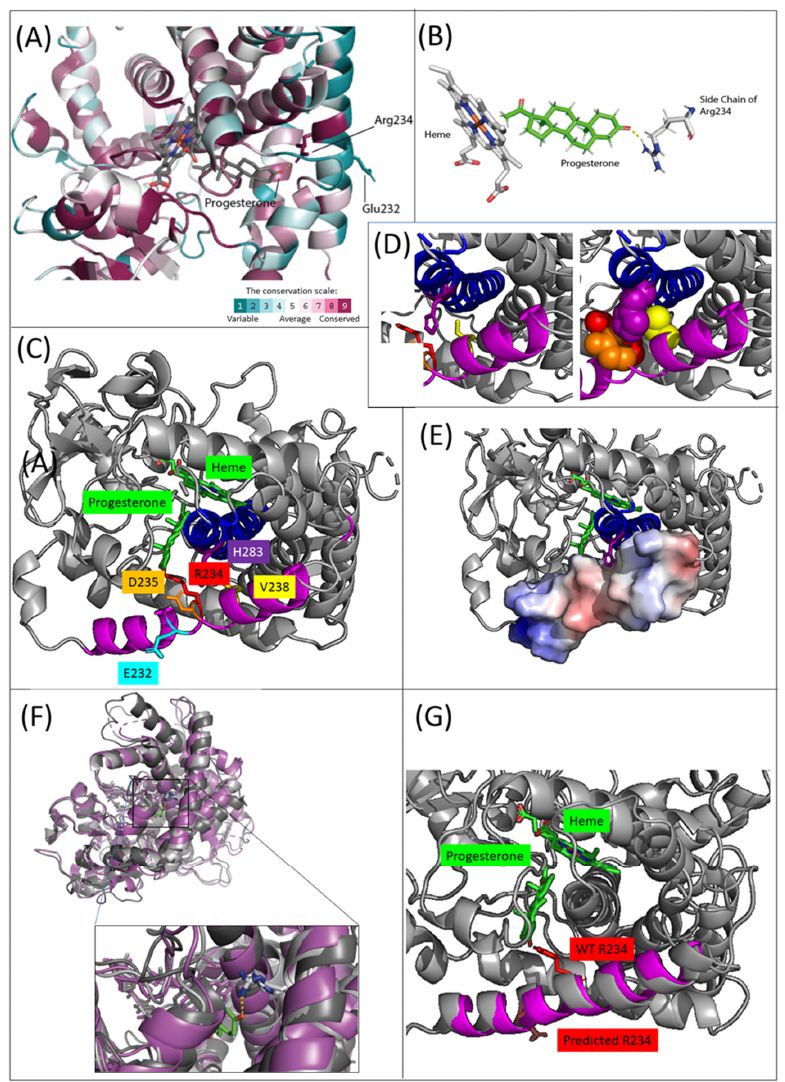
Figure 1. Highlighting evolutionary and structural information relevant to our case in the CYP21A2 structure. Legend: ( A ): the relevant part of the CYP21A2 structure colored by evolutionary conservation. The evolutionary conservation scale in ConSurf ranges from 1 (non-conserved, colored in cyan) to 9 (highly conserved, colored in burgundy). ( B ): The native CYP21A2 structure (4y8w), in which the hydrogen at the tail of the R234 side chain hydrogen-bonds with the progesterone’s O3, helping position the progesterone so that its carbon atom C21 on the other end lies near the heme. ( C ): Highlighting several structural elements: helices G and I are shown in magenta and blue, and residues E232, R234, D235, V238, and H283 are highlighted in different colors, with their sidechains shown as sticks. ( D ): Zooming in on the region where helix G and helix I touch each other, and showing the side chains of the relevant residues (as sticks—left panel, and spheres—right panel), the H283 (in purple) is seen to be positioned in the groove formed by the R, D, and V. The distances between the ring of H283 and the side chains of these residues are 4.1A (V238), 4.8A (D235), and 5.9A (R234). ( E ): The electrostatic potential of helix G (ranging from red for negatively charged to blue for positively charged) shows the groove that holds H283. ( F ): The side chains of the three PDB homologues (3qz1, a bovine homologue and 6b82 a zebra fish homologue) of the P45021A2 are shown superimposed. ( G ): The predicted structure by Phyre2 [20]. For clarity of representation, we show only helix G in magenta, R234 in red, and the bound substrates from the WT structure; the predicted R234 is facing away from the